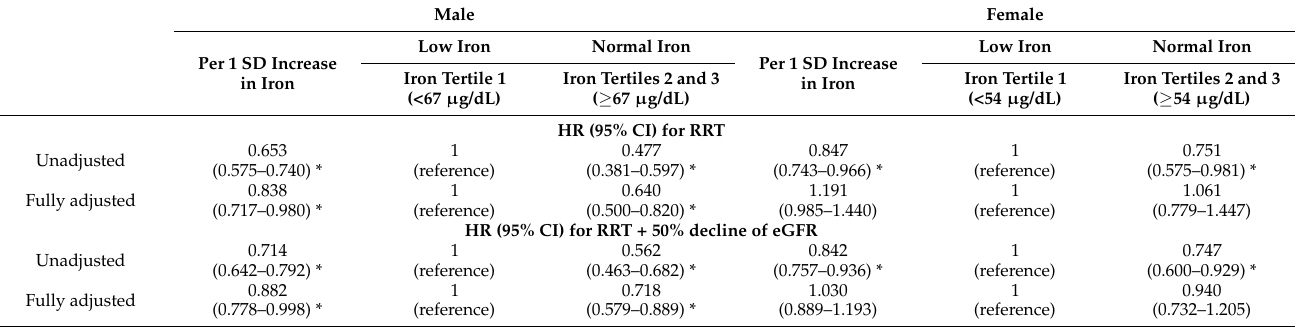
Table 3. Association of serum iron with renal outcomes divided by